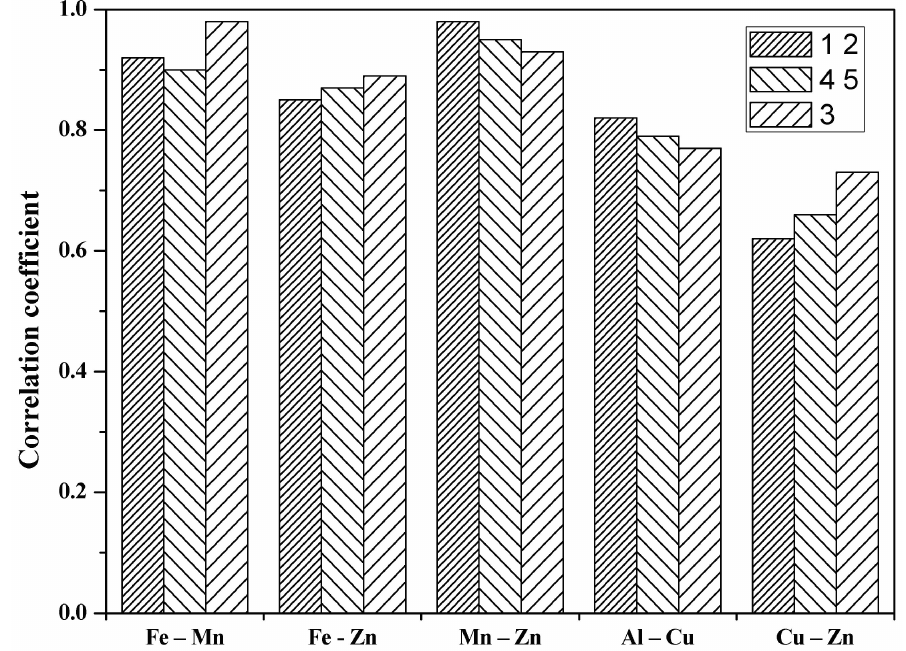
Figure 4. The highest correlation coefficients for water at all sampled